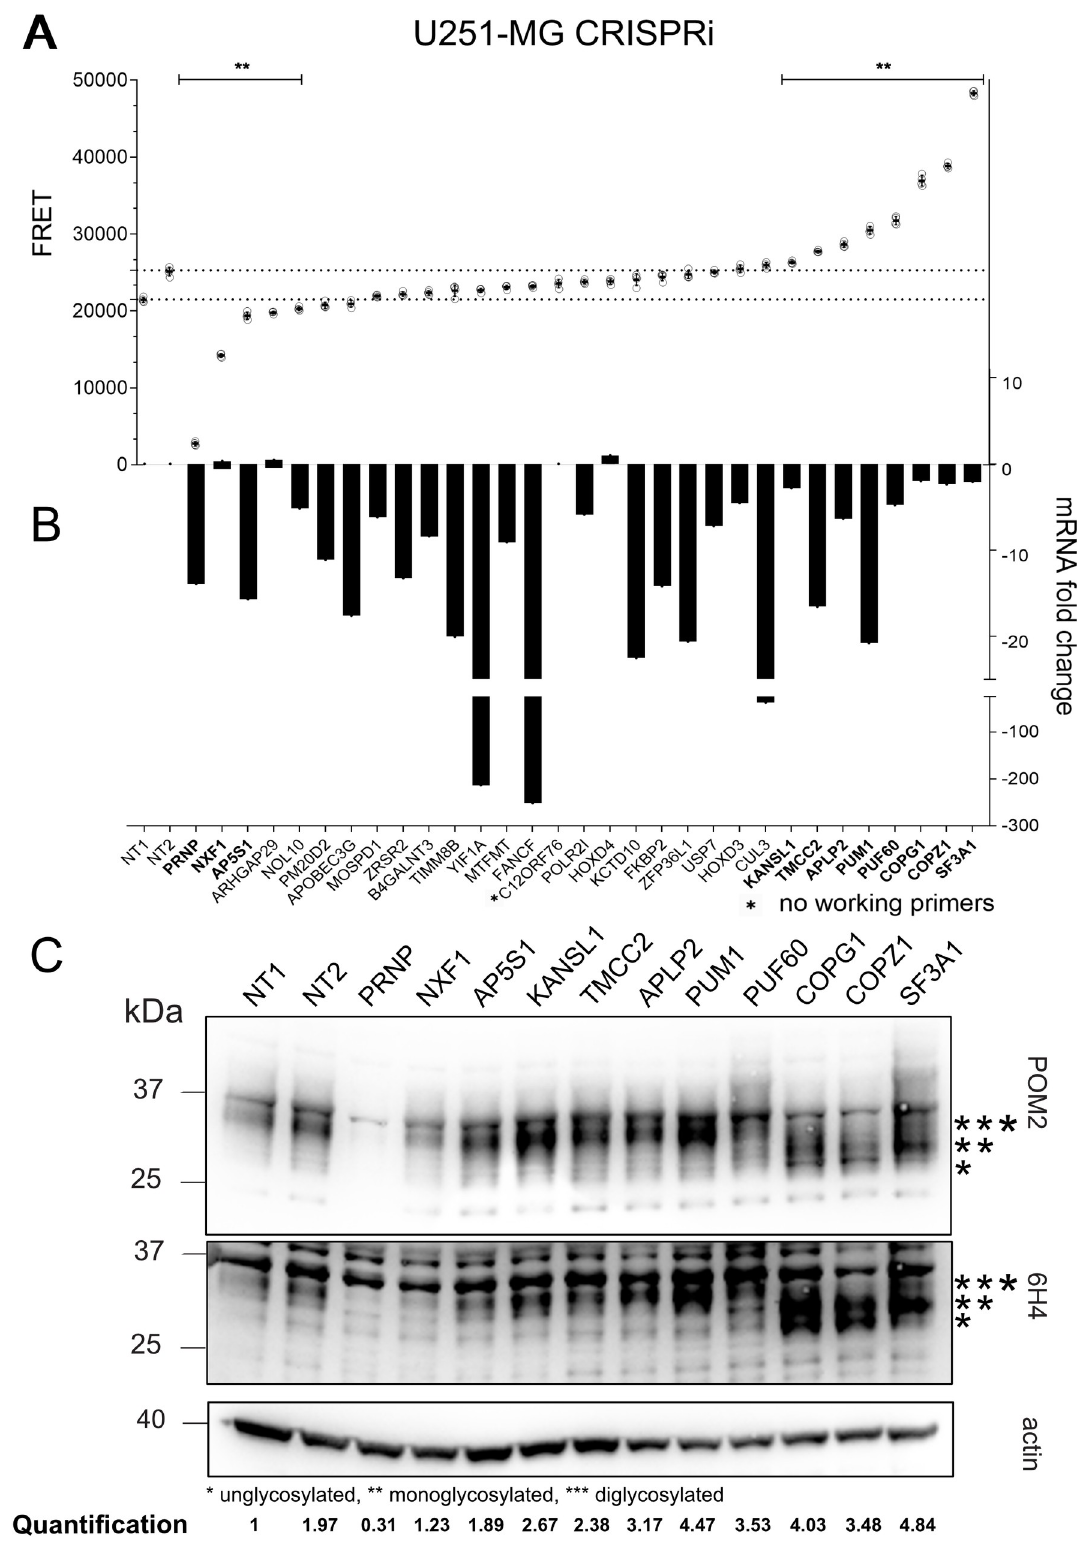
Fig 3. Hit validation in U251-MG cells by CRISPR interference. (A) PrP C protein levels of dCas9-KRAB-U251-MG cells transduced with gRNA CRISPRi lentiviruses against the targets depicted in B. Mean values ± SD (n = 4 technical replicates) are shown.